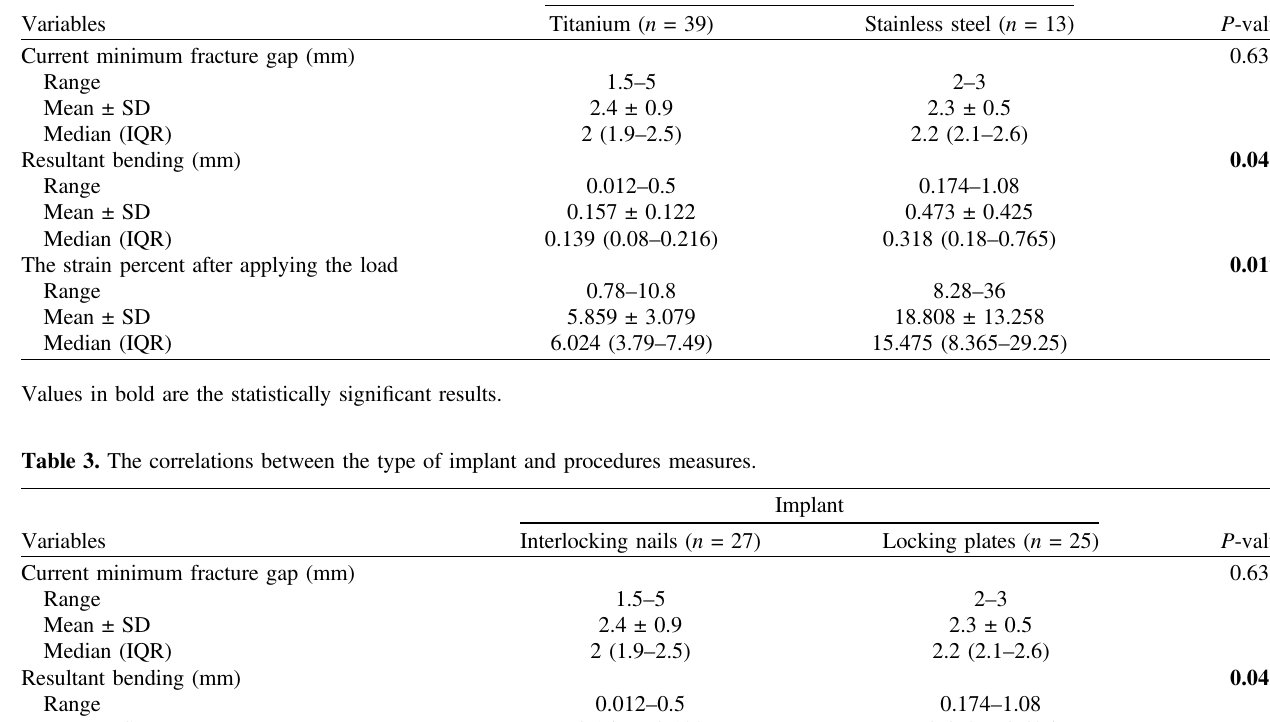
Fixation rod material